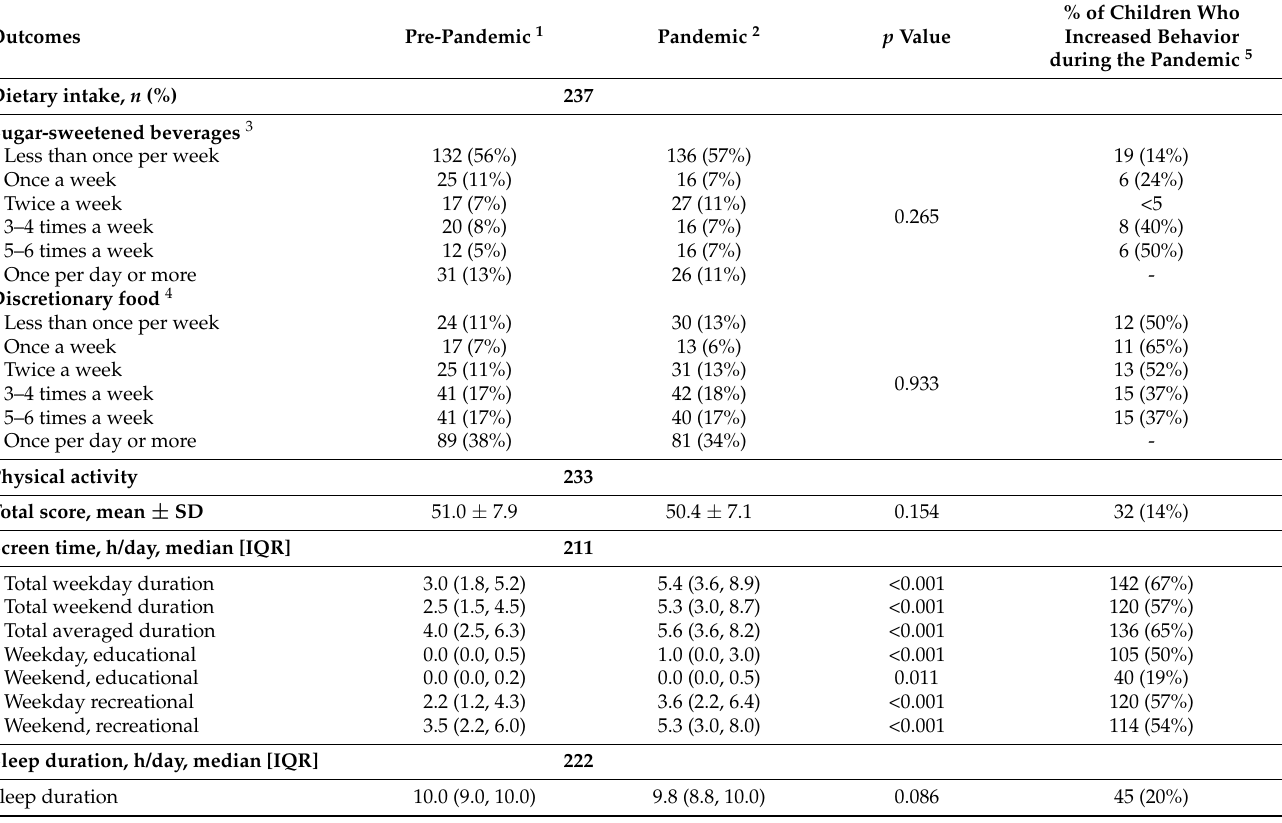
Table 2. Change in health behaviors between pre-pandemic and pandemic among children ages 4–12 years in the 4 cohorts participating in the Environmental influences on Child Health Outcomes Program ( n =